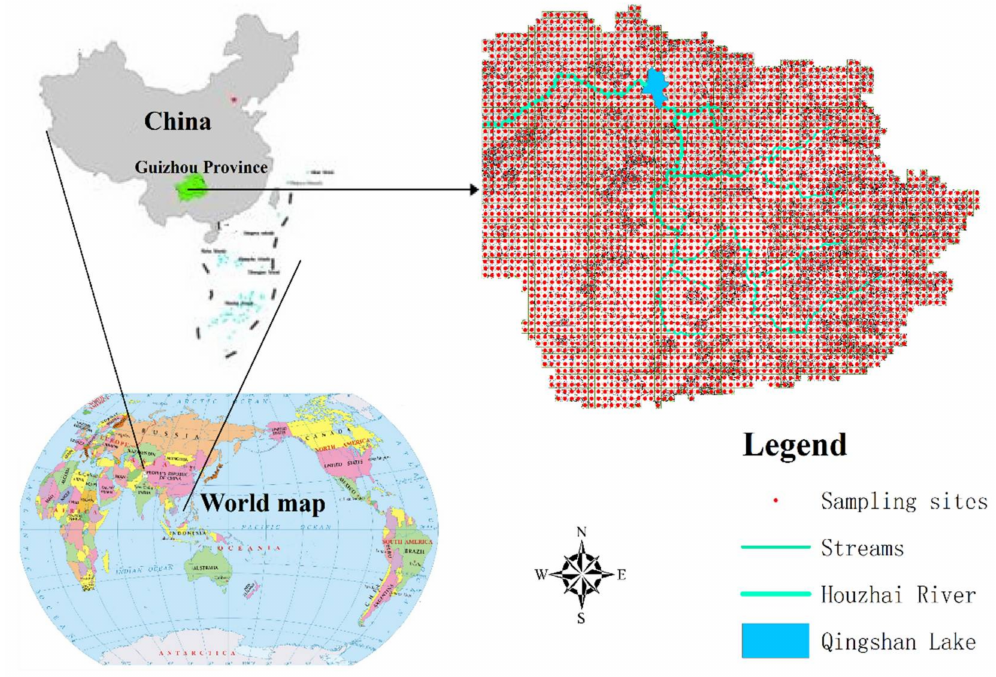
Figure 1. The location of Houzhai River basin and the distribution of sample